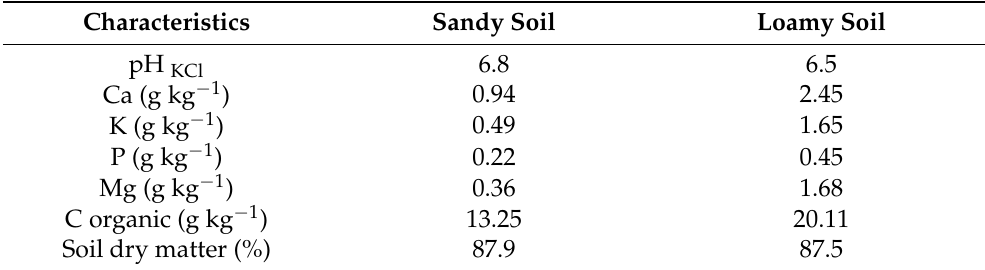
Table 4. Chemical characteristics of top soils used in the experiments. Characteristics Sandy